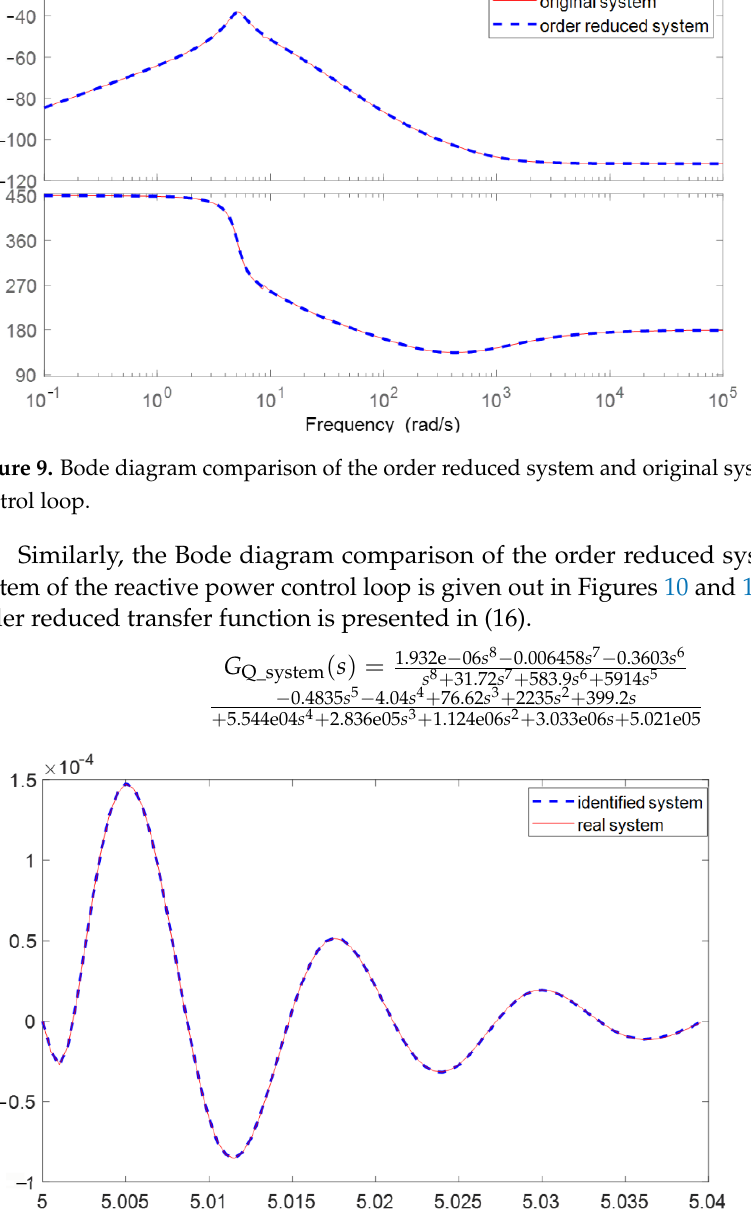
Figure 11. Bode diagram comparison of the order reduced system and original system of active power control loop. 4.2. Robust Controller Design The order of the weight function should not be too high. W 1 is generally a high pass characteristic and W 2 a low pass characteristic. W 3 can be set to a smaller constant. The weight functions selected for different oscillation modes can be different. The weight func- tions of the robust controller of this paper are given as, 1 ()